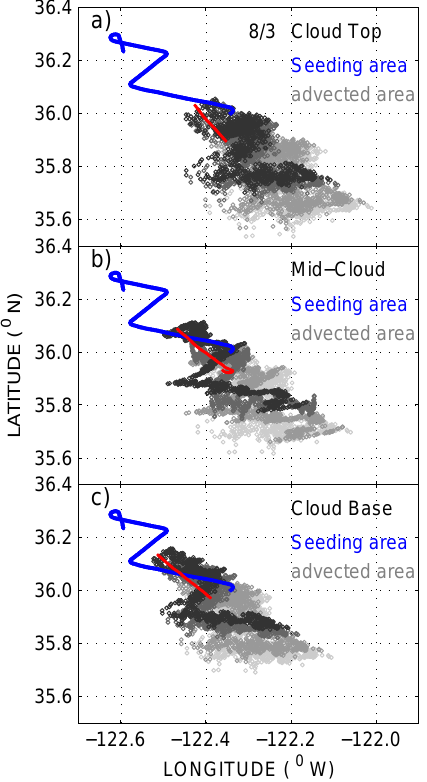
Figure 5. Salt seeding pattern (blue) with estimated advected seed- ing area at (a) cloud top, (b) mid-cloud and (c) cloud base. The seeding and post-seeding cloud sampling areas are shown as blue and red colors, respectively, at each level. The estimated seeding ar- eas for the post-seeding flights are shown as grey shades. The darker grey area points are the advected points calculated with the shorter possible elapsed